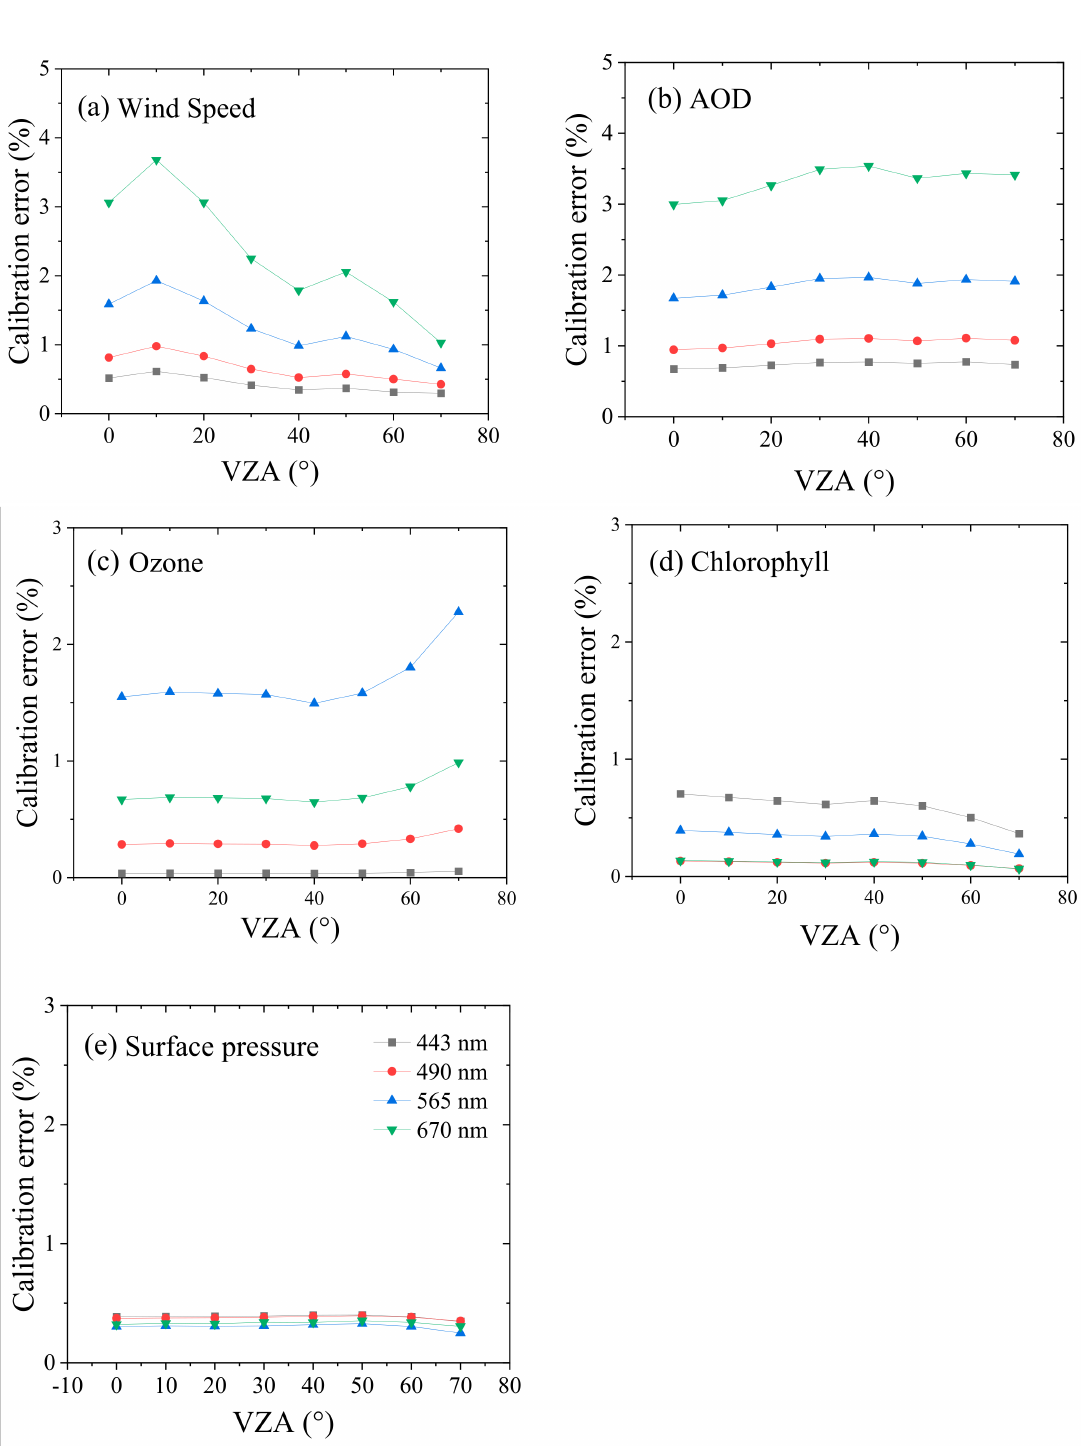
Figure 2. Theoretical Rayleigh radiometric calibration relative errors caused by the input parameter uncertainties plotted as a function of VZA at four visible bands of DPC (i.e., 443, 490, 565, 670 nm) in which that ( a ) wind speed, ( b ) AOD, ( c ) ozone column concentration, ( d ) chlorophyll concentration and ( e ) surface pressure, respectively. The calibration relative error is the average value at different solar and viewing zenith angles of 0–70 ◦ and relative azimuth angle of 0–180 ◦ when the sunglint angle is greater than 40 ◦